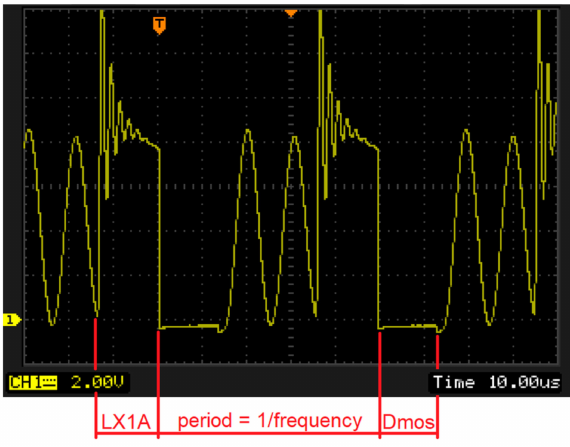
Figure 7. LX2A waveform with V OC = 120